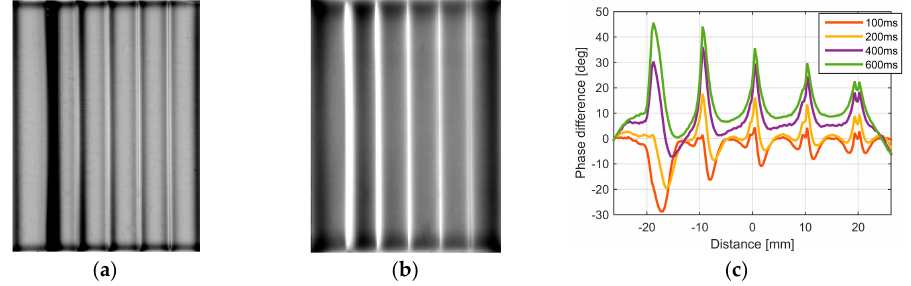
Figure 17. Results for a steel sample with five artificial defects, each of them with a 1 mm depth and inclination angles from left to right of 75°, 60°, 45°, 30°, and 0°, respectively. ( a ) t pulse = 0.1s; ( b ) t pulse = 0.6 s; ( c ) profiles for different heating pulses.